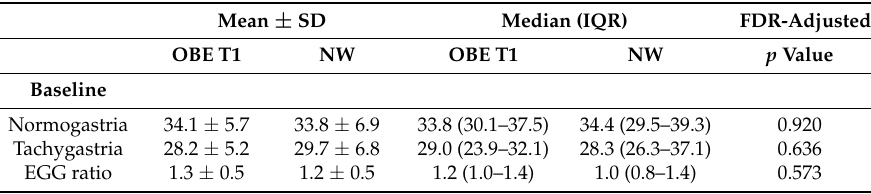
Table 2. EGG data of children with obesity before weight loss (OBE T1) and normal-weight control children